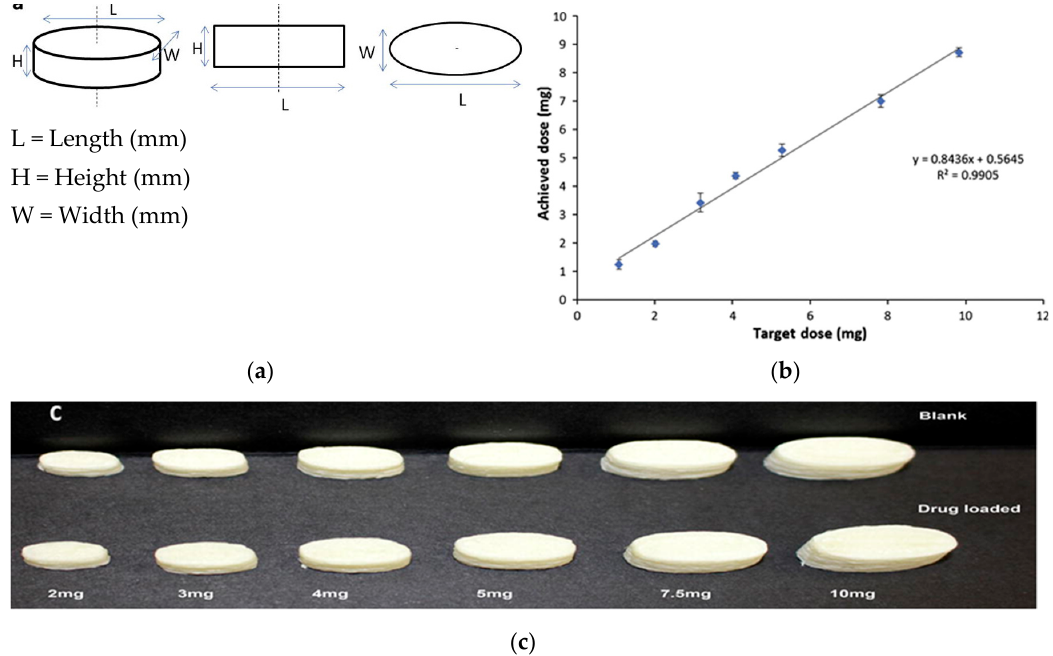
Figure 10. ( a ) Design of tablets, ( b ) the relationship between the target and achieved prednisolone dose, and ( c ) PVA based FDM 3D printed tablets having different dose strengths [56]. Target or theoretical dose D (mg) = M.S /